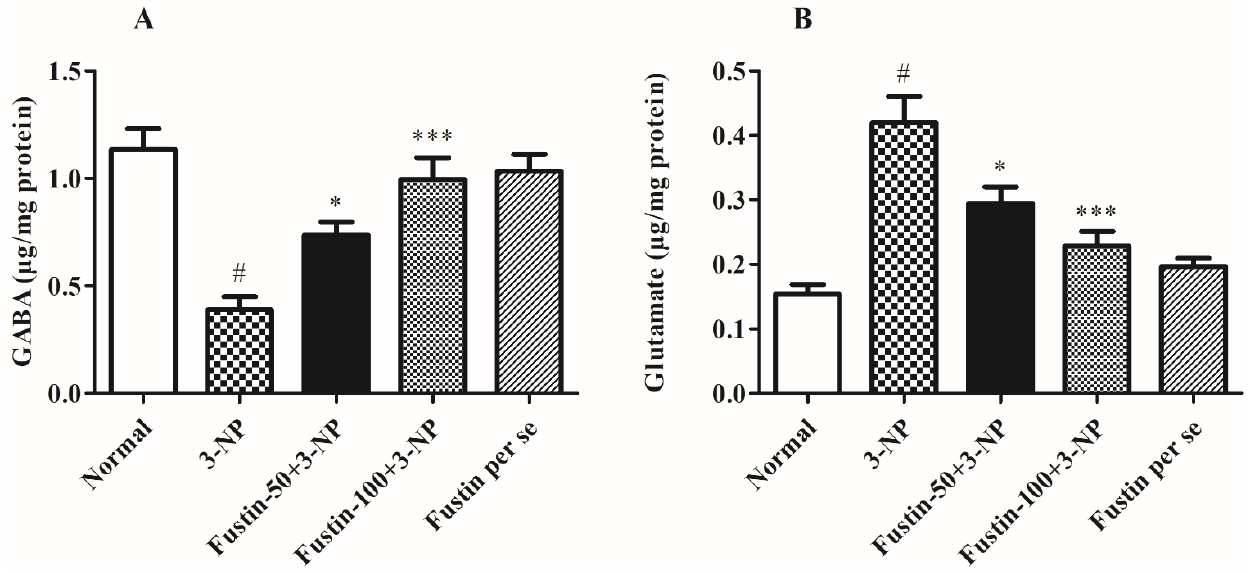
Figure 8. Effect of fustin on neurotransmitter levels against 3-nitropropionic acid-induced Huntington’s-like effects in rats ( A ) GABA, ( B ) Glutamate. Values are expressed as mean ± S.E.M. ( n = 6). Values are statistically significant at # p < 0.05 vs. negative control group, * p < 0.05 vs. 3-nitropropionic acid, *** p < 0.001 vs. 3-nitropropionic acid, respectively (One-way ANOVA followed by Tukey’s test).